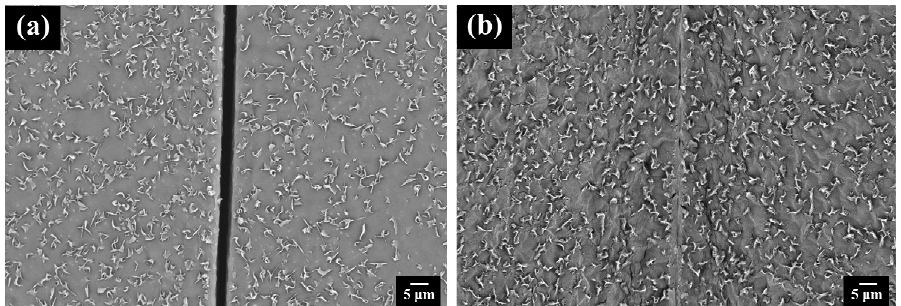
Figure 14. SEM images of a micro-scratched DA-PEBF-2 sample ( a ) before and ( b ) after self-repair.